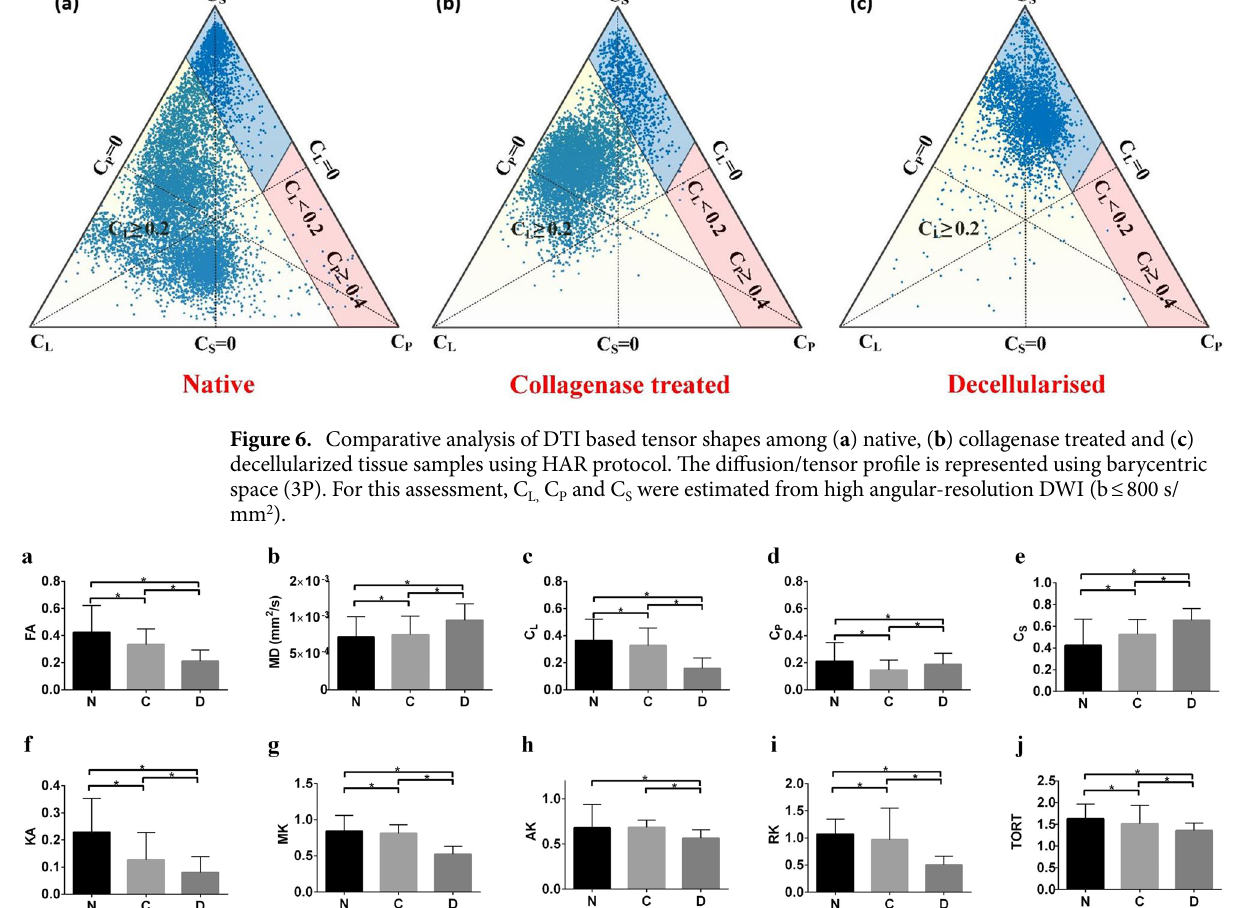
Figure 7. Quantification of changes in arterial tissue microstructural organization using HAR protocol. ( a – e ), DTI (b ≤ 800 s/mm 2 ) based directionally invariant indices are displayed as columns (mean) for each ROI. ( f – j ), DKI (b ≤ 2500 s/mm 2 ) based parameters are displayed as columns (mean) for each ROI. KA kurtosis anisotropy, MK mean kurtosis, AK Axial kurtosis, RK radial kurtosis, TORT tortuosity. Three native tissue (N) samples, three collagenase treated tissue (C) samples and three decellularized tissue (D) samples were used for comparison. (n = 12, one ROI per slice, 4 slices per sample). Values represent mean ± SD. * p <